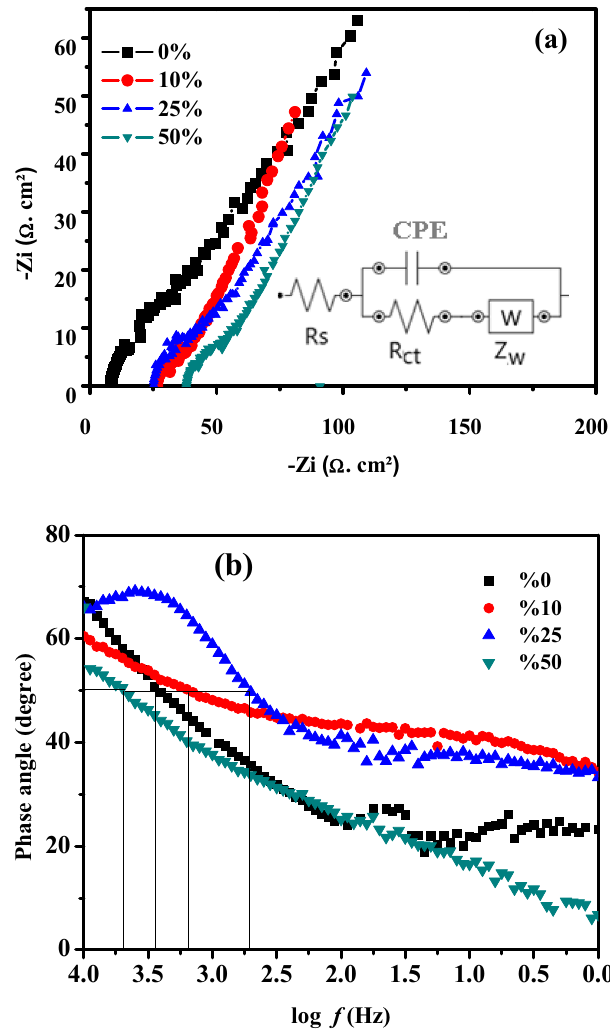
Figure 7. Nyquist ( a ) and Bode phase angle ( b ) plots of P3HT/SWCNTs electrodes with different SWCNTs